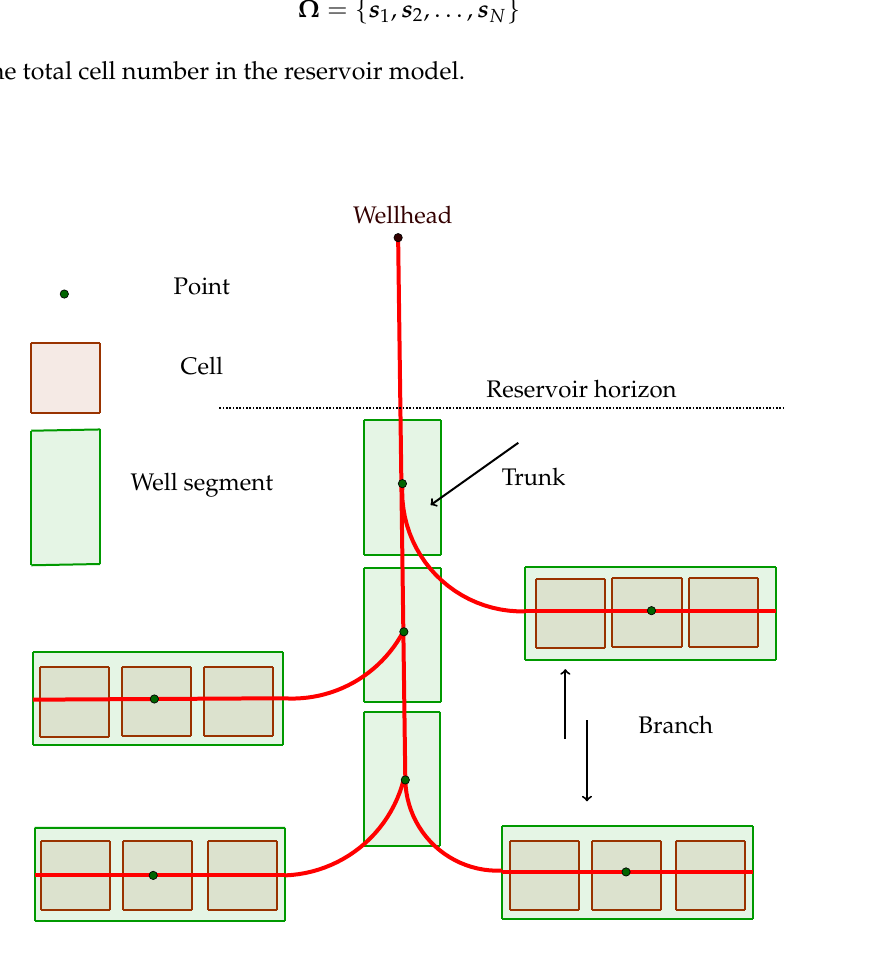
Figure 4. Multilateral well representation